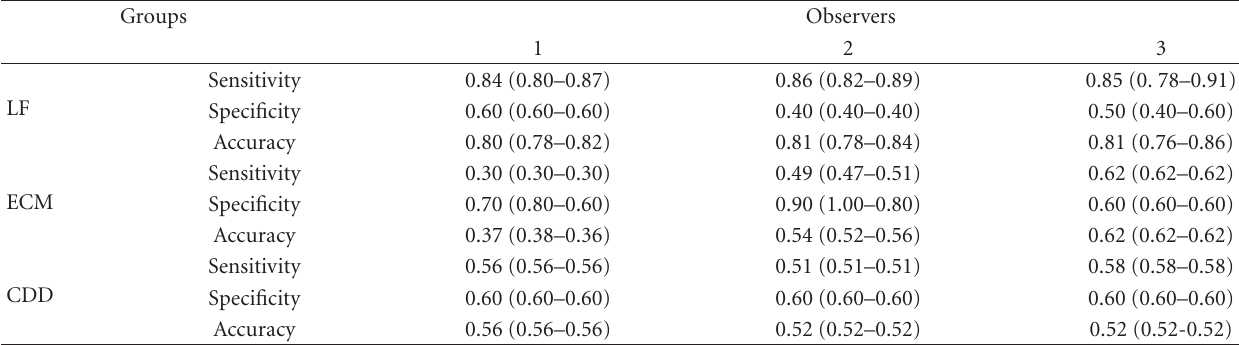
Table 1: Average sensitivity and specificity values (maximum and minimum) of CDD, LF, and ECM for detection of residual caries. Groups